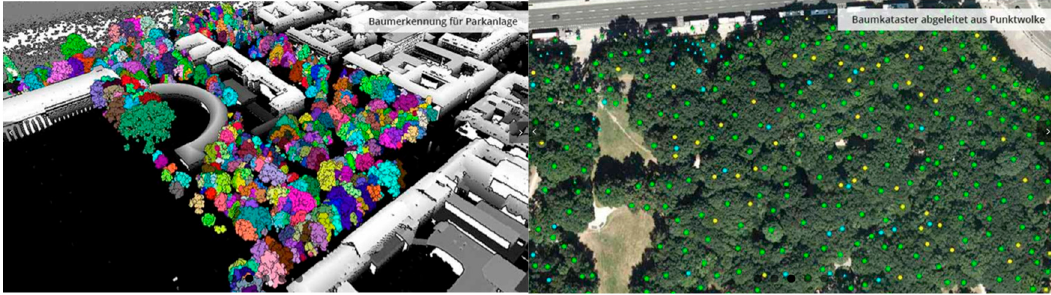
Figure 2. Two examples of derived vegetation objects based on 3D point cloud analysis.